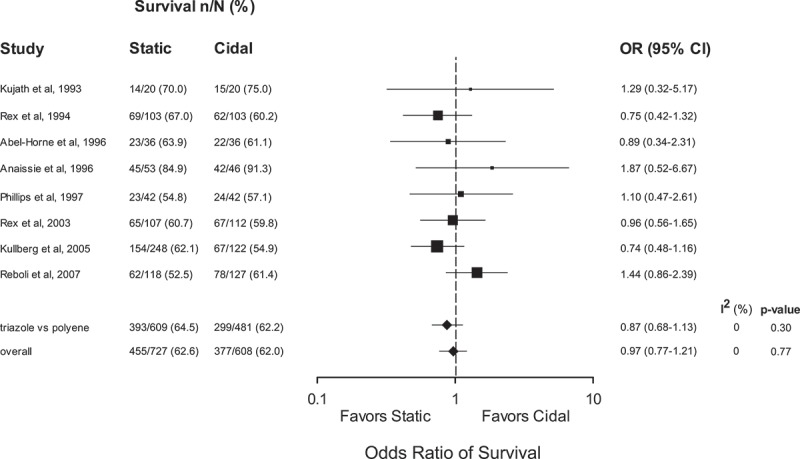
Survival to hospital discharge following therapy for trials comparing fungicidal and fungistatic therapy of invasive candidiasis and/or candidemia. Odds ratios (ORs) are pooled using a random-effects model on a logarithmic scale. The size of the squares is proportional to the reciprocal of the variance of the studies. CI: confidence interval, n/N: frequency of finding.